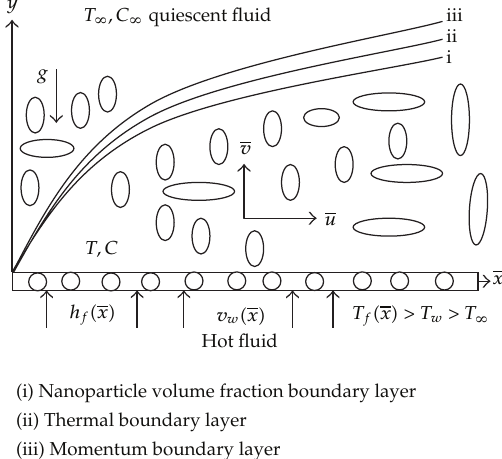
Figure 1: Coordinate system and flow